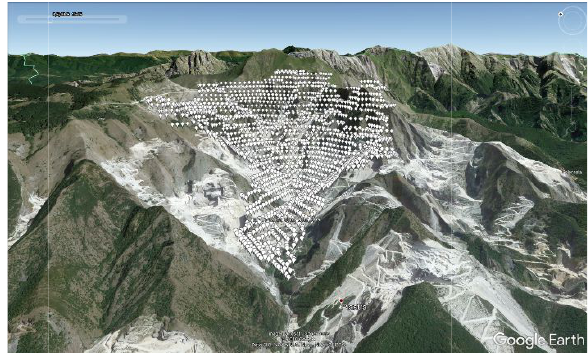
Figure 6. Spatial distribution of